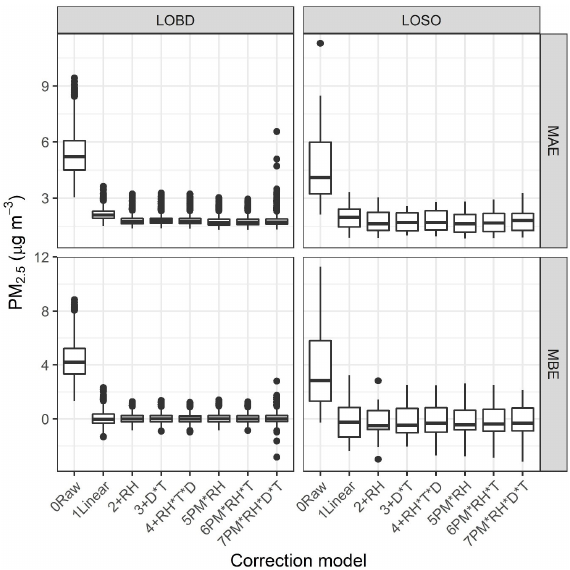
Figure 4. Performance statistics including mean bias error (MBE) and mean absolute error (MAE) are shown by correction method (0–7), where each point in the boxplot is the performance for either a 12-week period excluded from correction building (“LOBD”) or a single state excluded from correction building